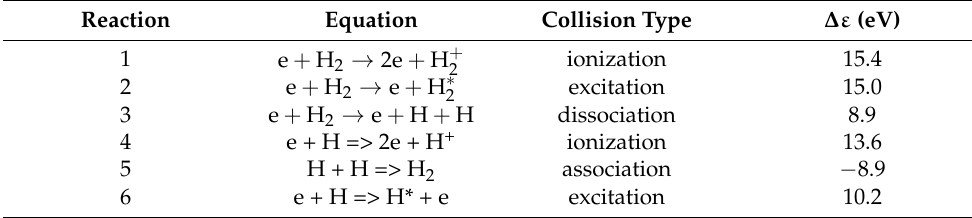
Table 1. The collision process involved.